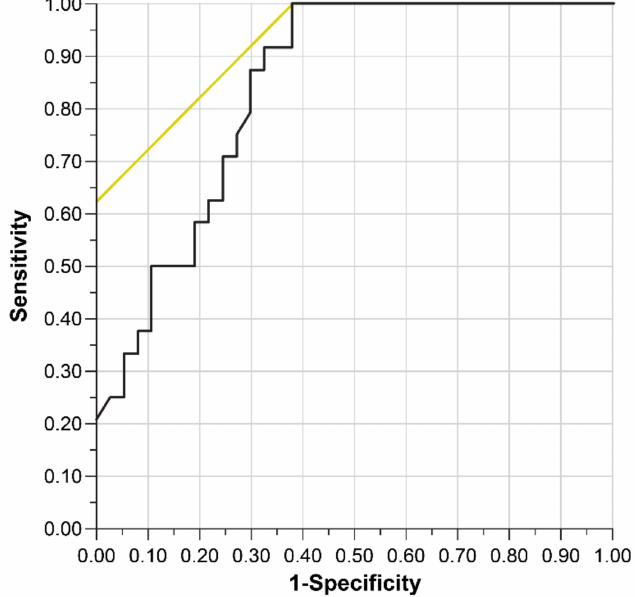
Figure 1. Receiver operating characteristic curve for prediction of